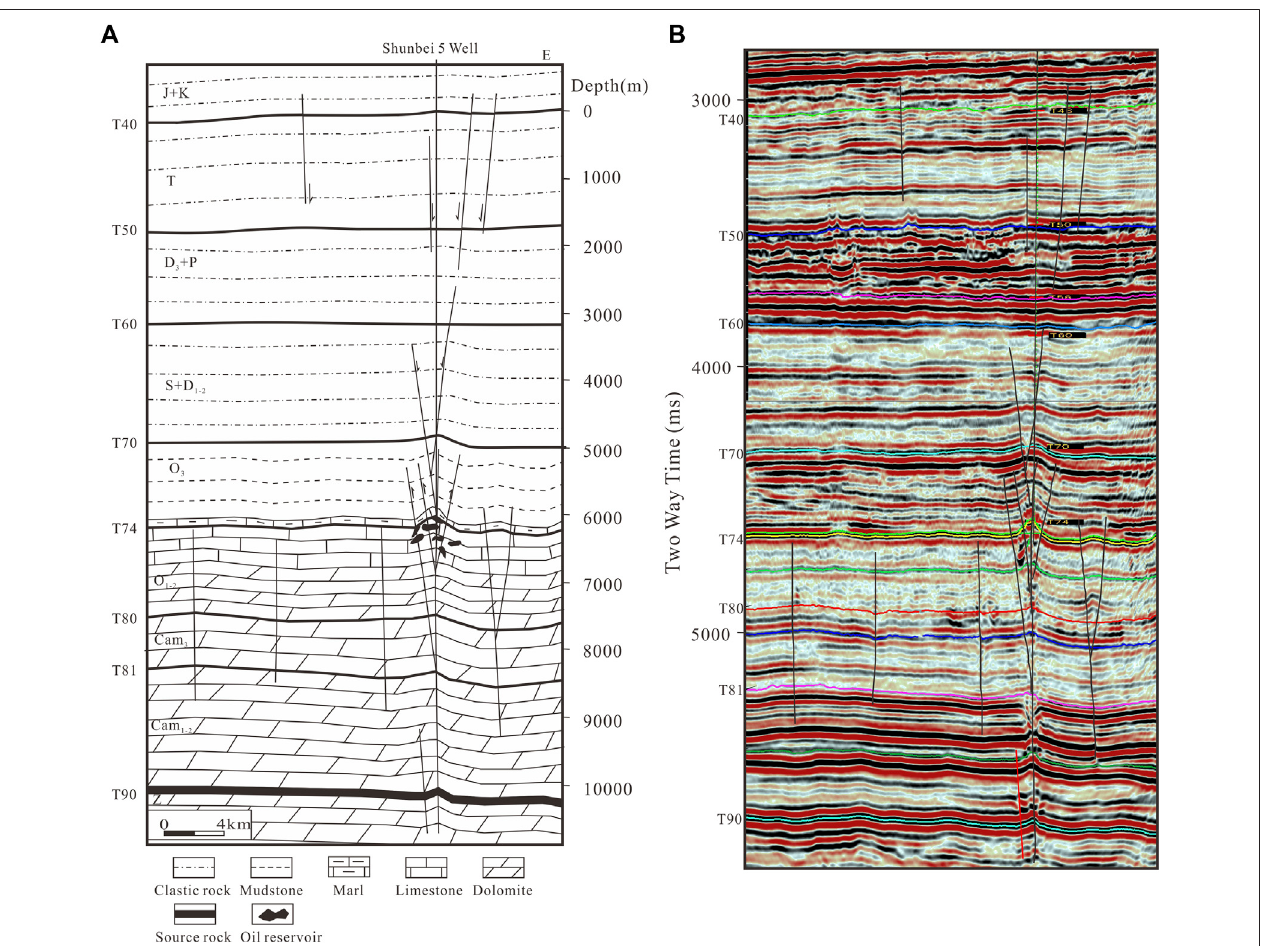
FIGURE 11 | Reservoir modeling (A) and vertical pro fi le (B) of the Shunbei 5 reservoir.